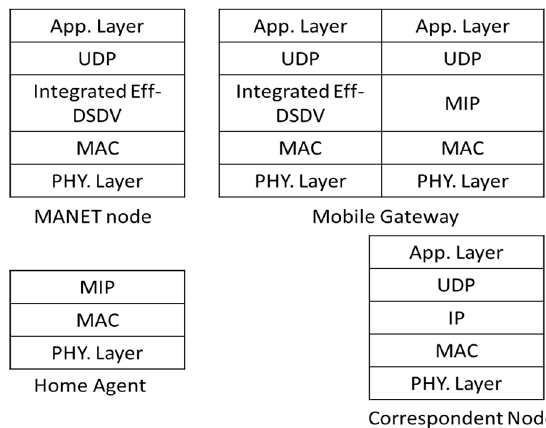
Figure 8. An e ffi cient integrated routing for interconnecting mobile MANET and the Figure 8. An efficient integrated routing for interconnecting mobile MANET and the internet.